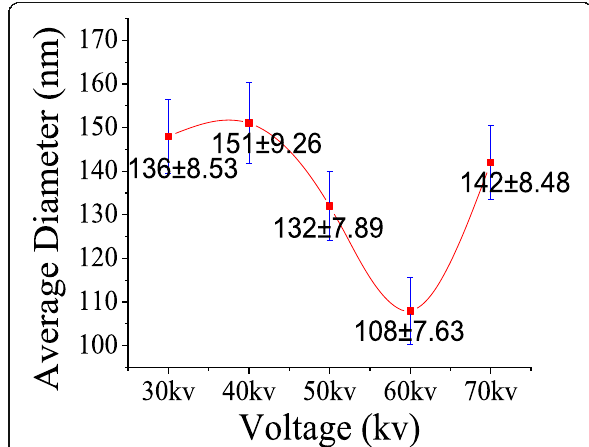
Fig. 5 The effect of applied voltage on the average diameter